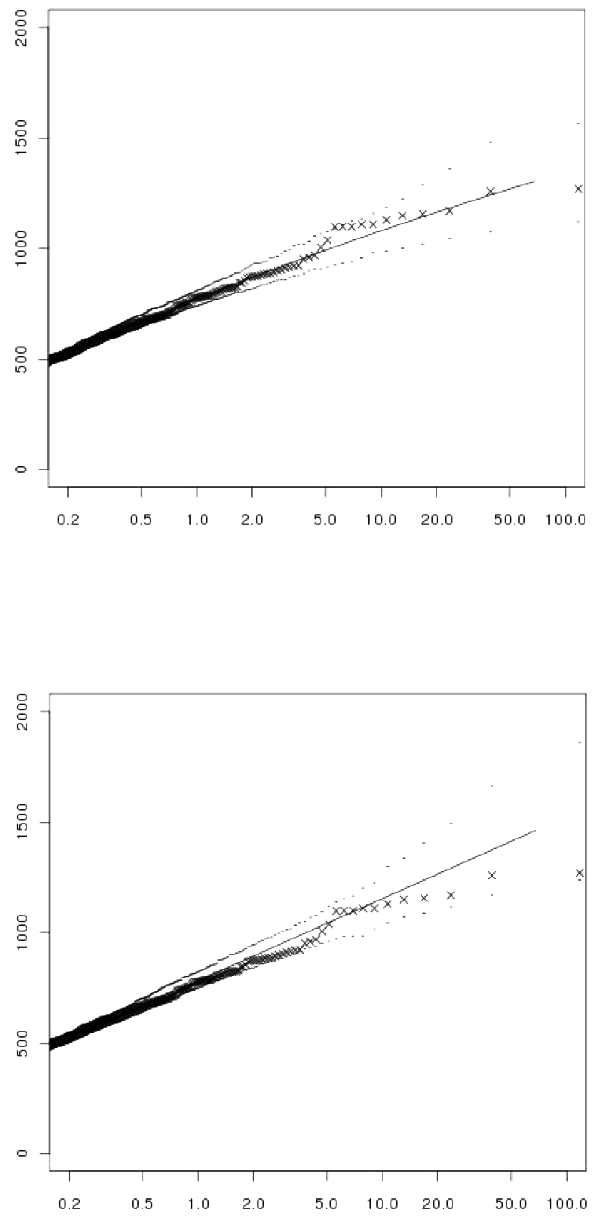
Figure 2. Return level plot (POT approach, maximum likelihood es- timators). Top: assumption ξ (cid:54)= 0, bottom: assumption ξ = 0. Hori- zontally: − 1/log ( 1 − 1 /N) , logarithmic scale, vertically: estimated N -year return level. Continuous line: estimation using the GPD, crosses: sample points, dots: 95% confidence interval.